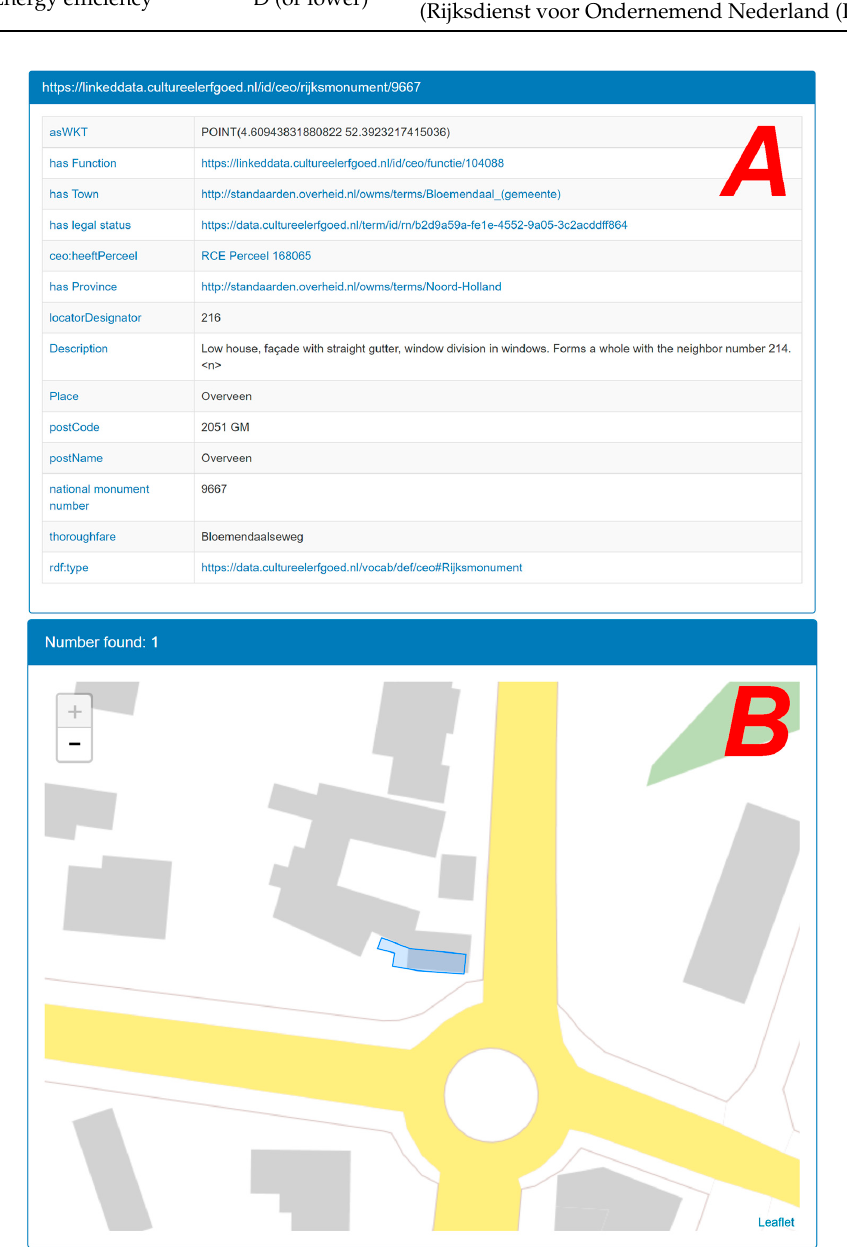
Figure 6. Table ( A ) and map ( B ) view panes of the KKG browsing application. The